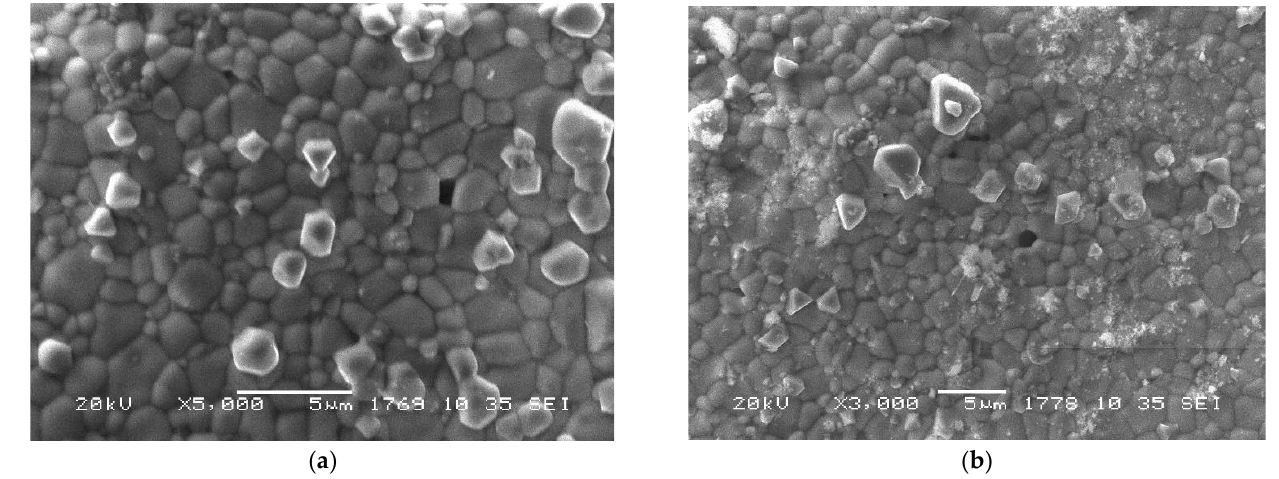
Figure 10. SEM images of the composites ( a ) NiCu – LCNb and ( b ) NiCo – LCNb after calcination at 1100 °C.